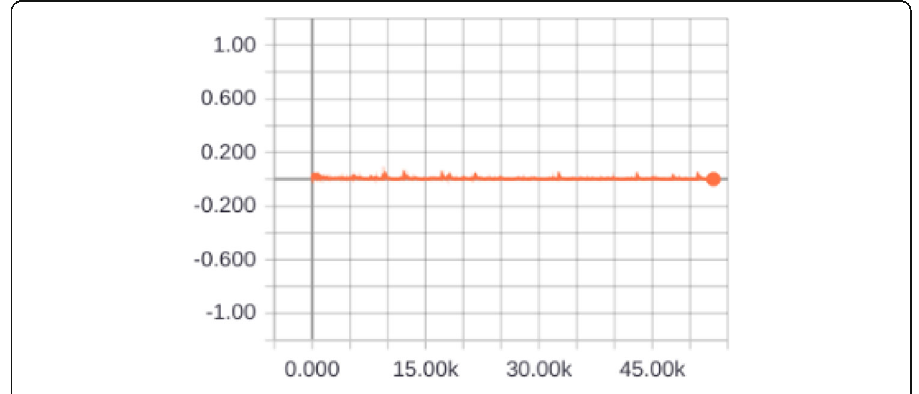
Fig. 8 Steps vs objectness loss in